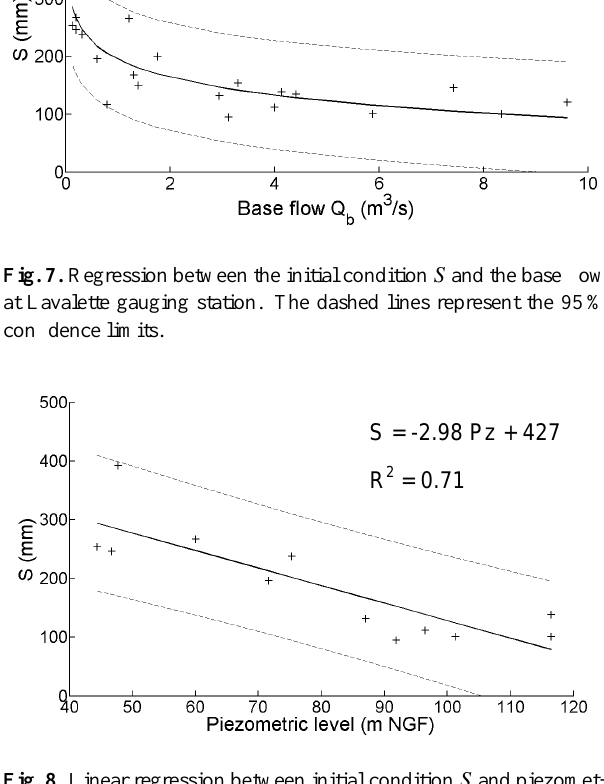
Table 5. Performances of selected simulations performed with rain gauge (G) or radar rainfall (R) input using Nash criterion, relative error on peak discharge (E RPD ) , error on time to peak (Etp) and bias on volume (Bias).